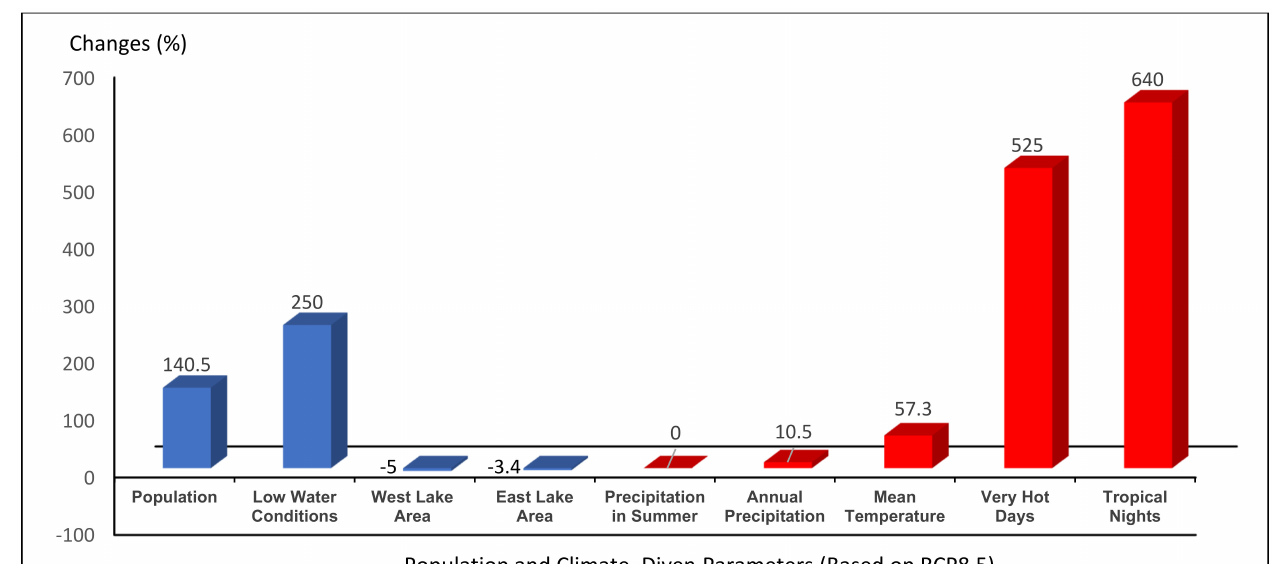
Figure 20. Changes in population and climate-driven parameters in the study area (blue represents observed data and red refers to future projections for